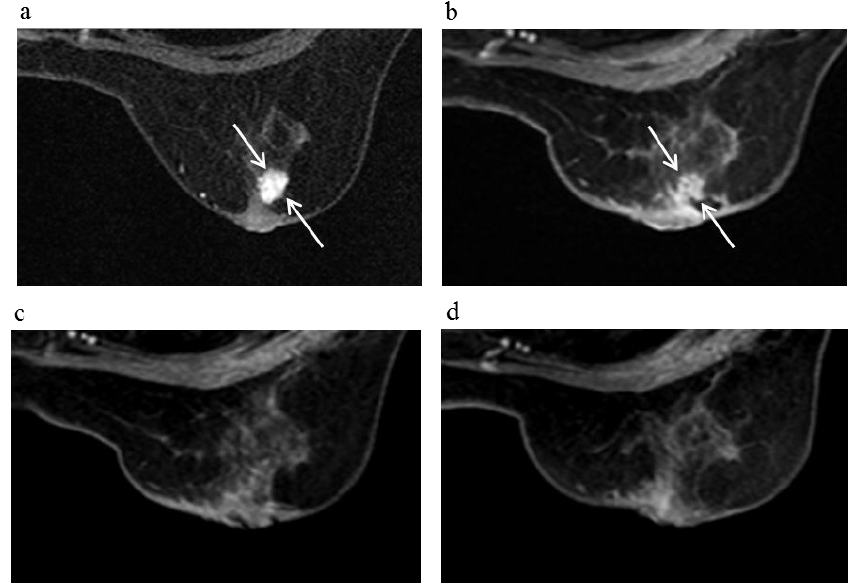
Figure 7. A 59-year-old female (case 18 in Tables 1–3) with right breast cancer (cT1cN0M0). CE breast MRI ( a ) revealed a breast tumor before KORTUC II therapy, the region of tumor was 11 mm (arrows). 6 months after the completion of KORTUC II, the tumor does not still disappear on breast CE MRI (( b ): arrows); However, after 18 months ( c ) and 30 months ( d ), a complete response was achieved and no recurrence was identified on CE breast MRI.